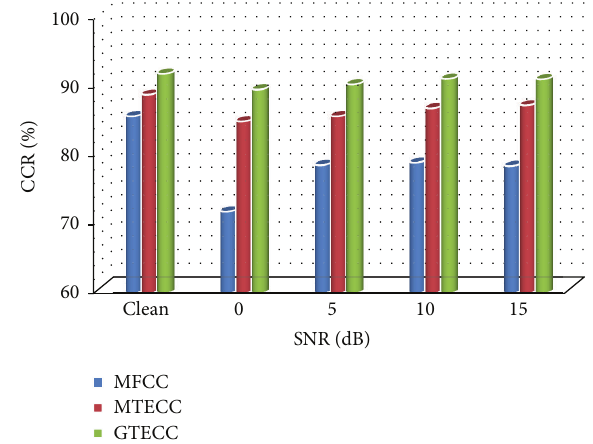
Figure 8: Feature performance in clean and noisy condition.